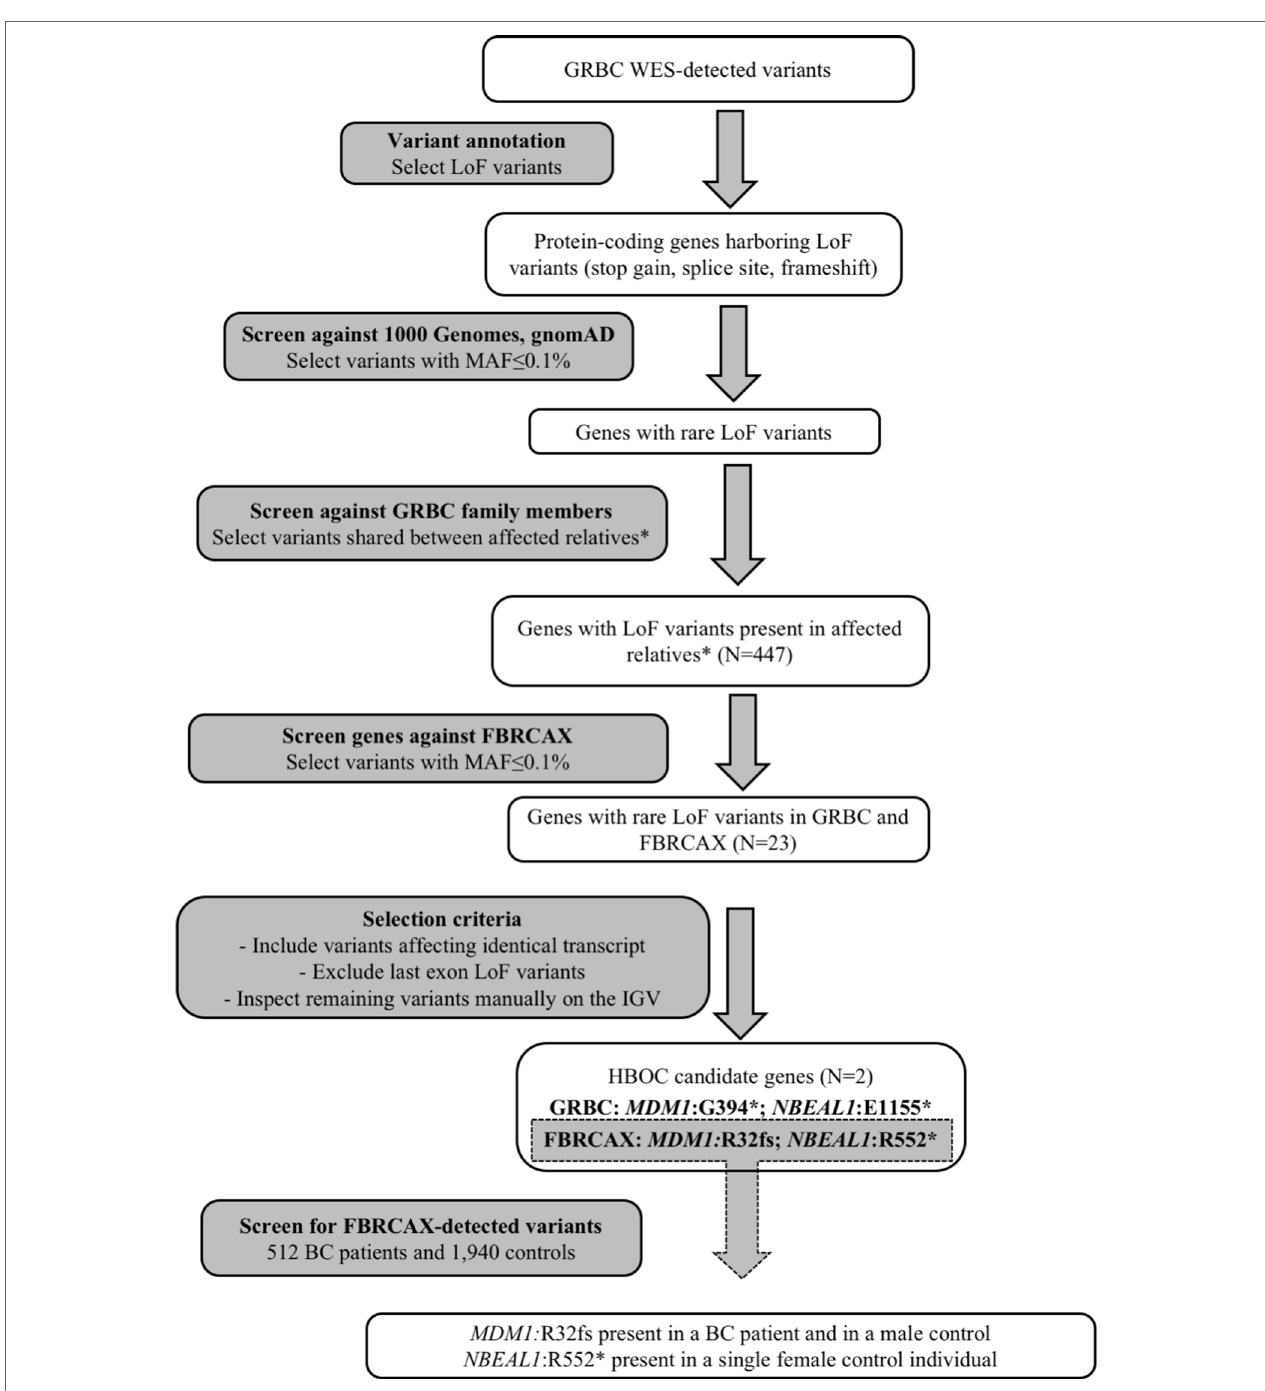
FIGURE 1 | Gene-based prioritization workflow. *For families where this was possible to be ascertained.